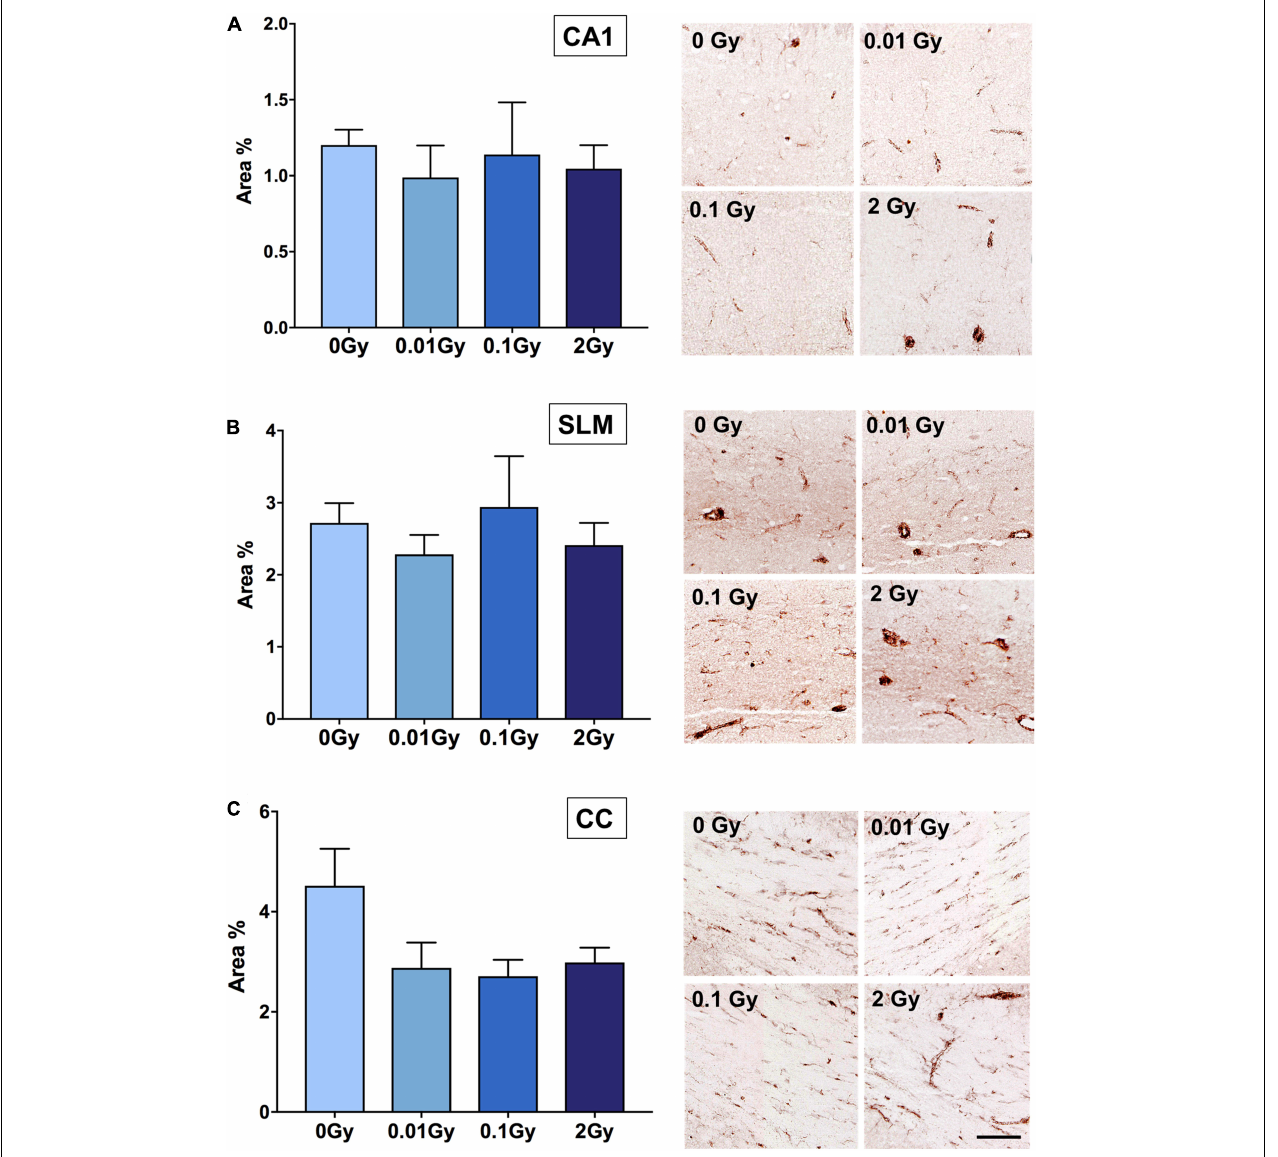
FIGURE 3 | TSPO expression in hippocampal regions after gamma irradiation, measured as area% positive immunostaining with DAB. Regions measured were (A) CA1 (stratum radiatum), (B) stratum lacunosum moleculare (SLM), and (C) corpus callosum (CC). Whilst a trend toward a downregulation in TSPO expression was observed after 0.01 Gy compared to 0 Gy controls in the CA1 region, SLM and CC, this did not reach statistical significance ( p > 0.05). A trend toward a downregulation after 2 Gy was also demonstrated in the CA1, SLM, and corpus callosum, though this also did not reach significance ( p > 0.05). n = 4–5 animals/group. Scale bar = 40 µ